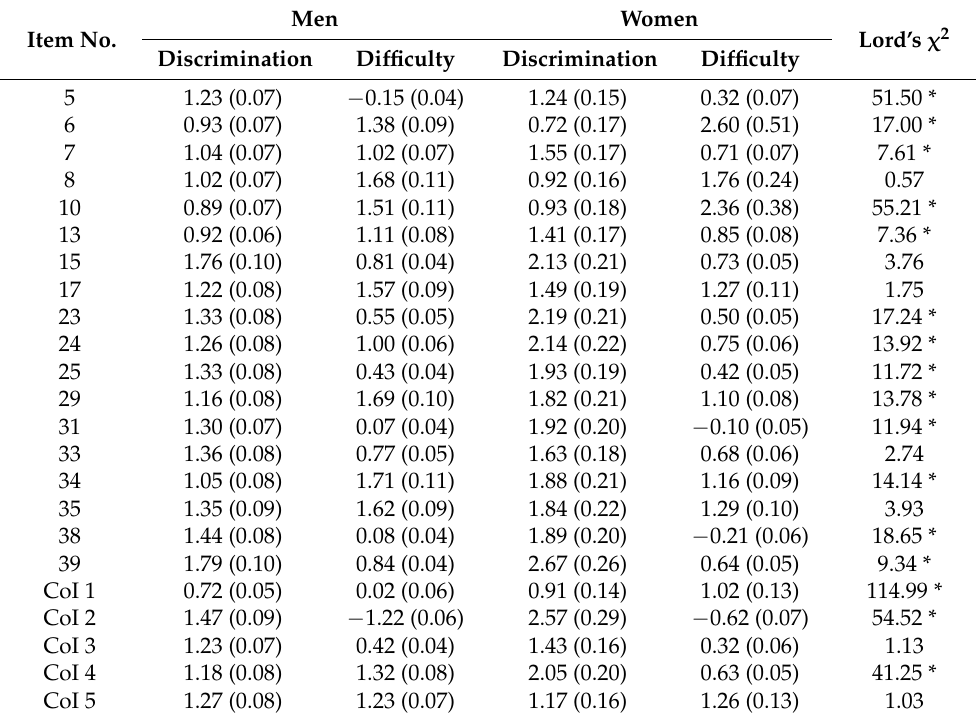
Table 4. Gender differences of item